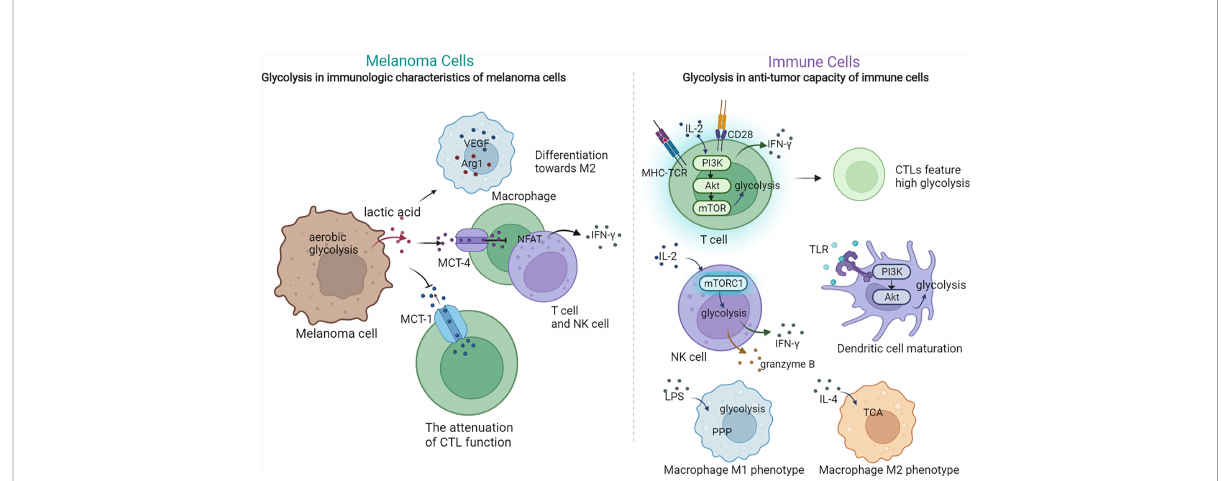
FIGURE 2 The crosstalk between glycolysis and tumor immunology in melanoma. The dysregulation of glycolysis could exert regulatory multiple effects on the immunologic characteristic of tumor cells and the anti-tumor capacity of immune cells. On one hand, the activated glycolysis in melanoma cells lead to extracellular lactic acid accumulation, which can affect the function of macrophage, T cells and NK cells. On the other, glycolysis in T cells, NK cells and macrophages can also modulate their function and anti-tumor